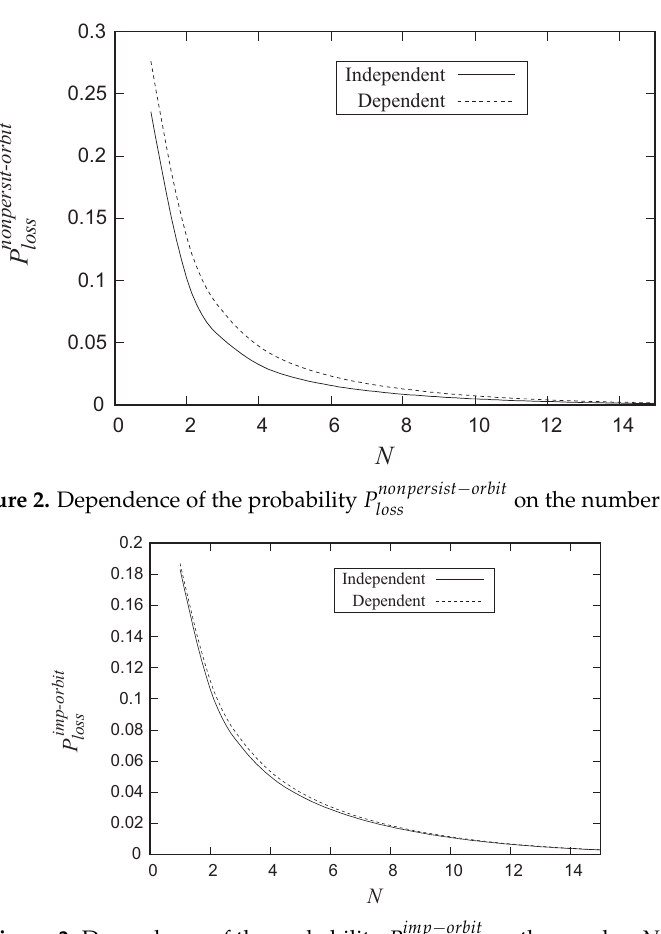
Figure 3. Dependence of the probability P imp